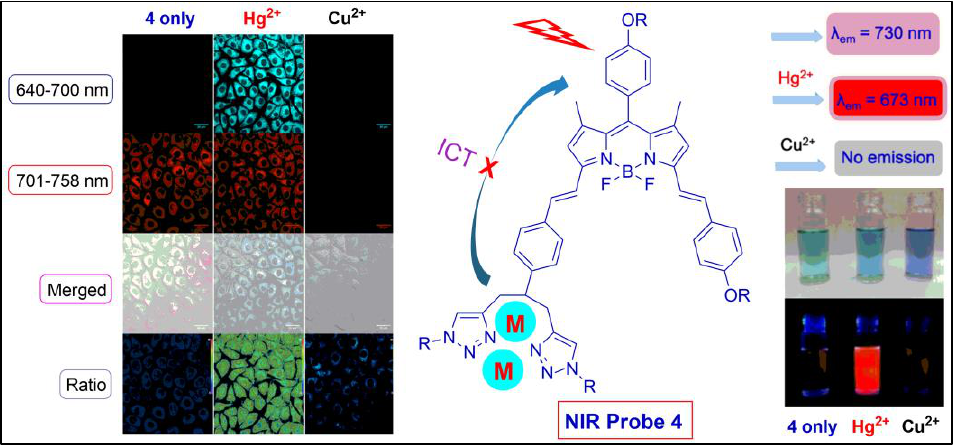
Figure 5. Fluorescence recognition mechanism of probe 4 with Hg 2+ and Cu 2+ ions. Fluorescence images of Hella cells pretreated with probe (6 µ M) for 30 min and after incubated with Hg 2+ (120 µ M) or Cu 2+ (120 µ M) for 0.5